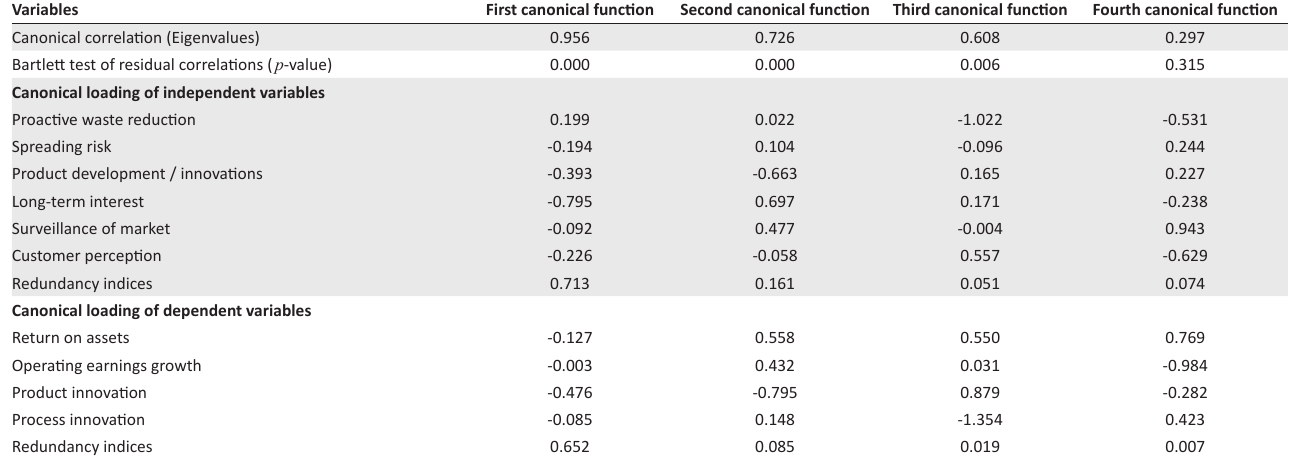
TABLE 8: Canonical correlations and loadings. Variables